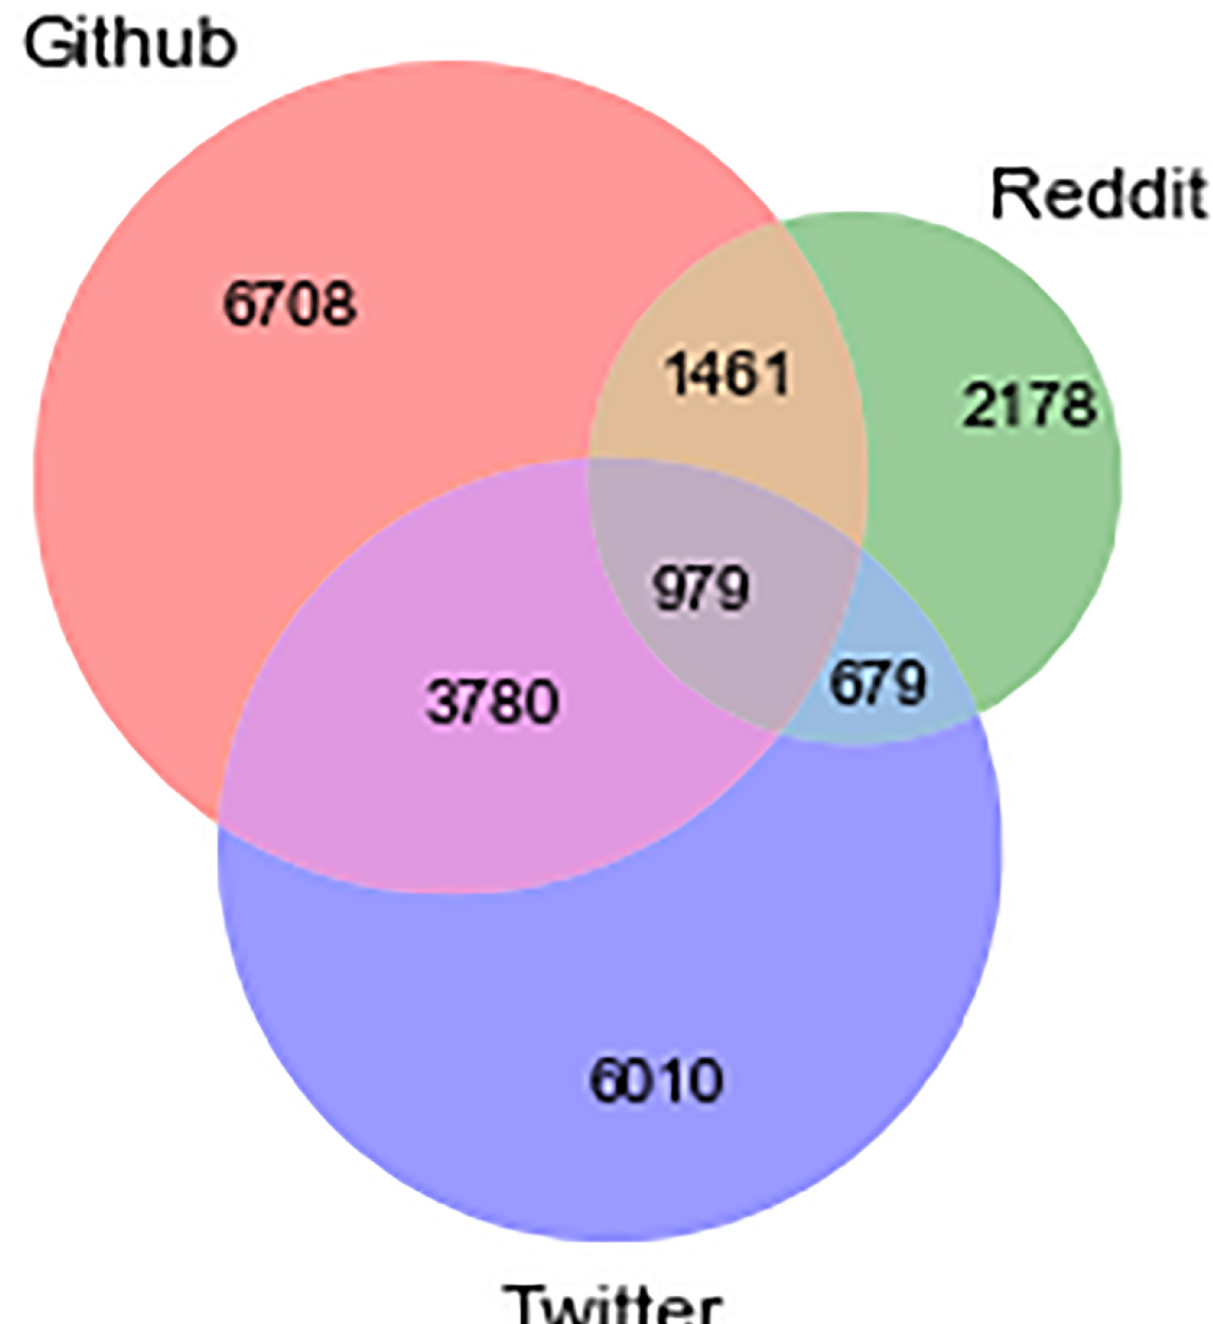
Fig 2. The overlap of software vulnerabilities discussed across the multiple social